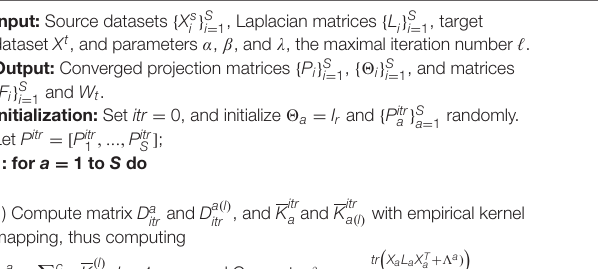
Algorithm 1: Multi-source adaptation